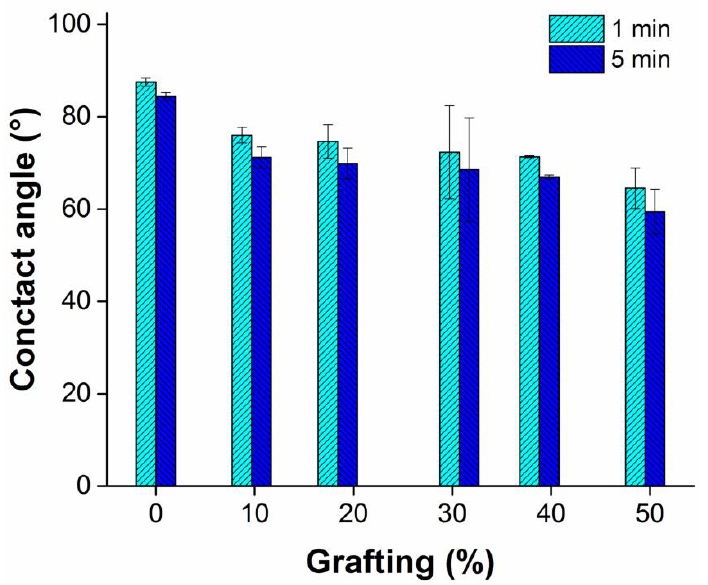
Figure 9. The contact angle of PP- g -MMA films showed a change from hydrophobic to hydro- philic.